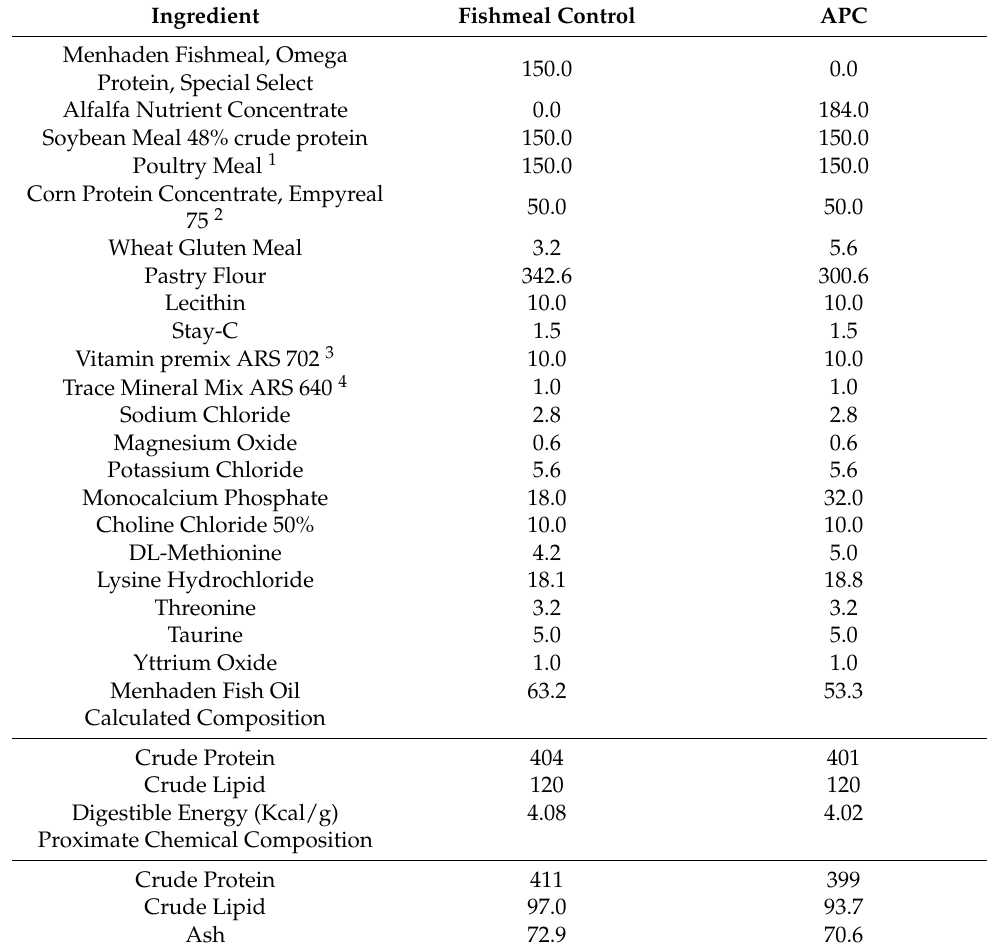
Table 2. Composition (g/kg) of diets to evaluate alfalfa protein concentrate (APC) replacing fishmeal in a diet for yellow perch ( Perca flavescens